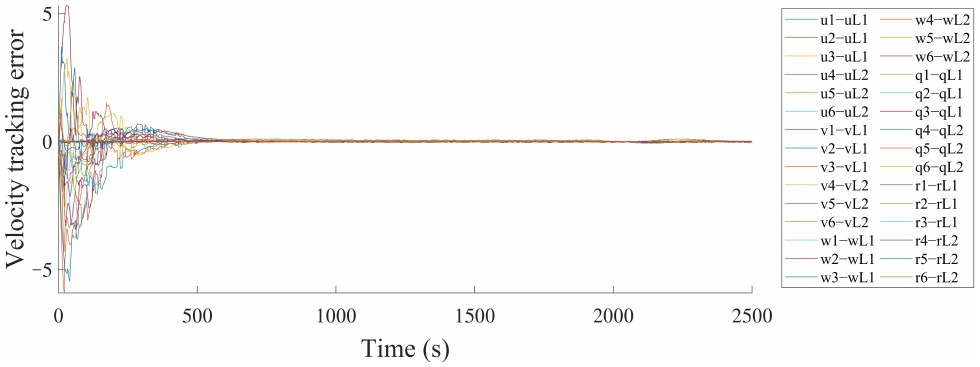
Figure 11. The velocity tracking errors of a multiple stochastic AUV